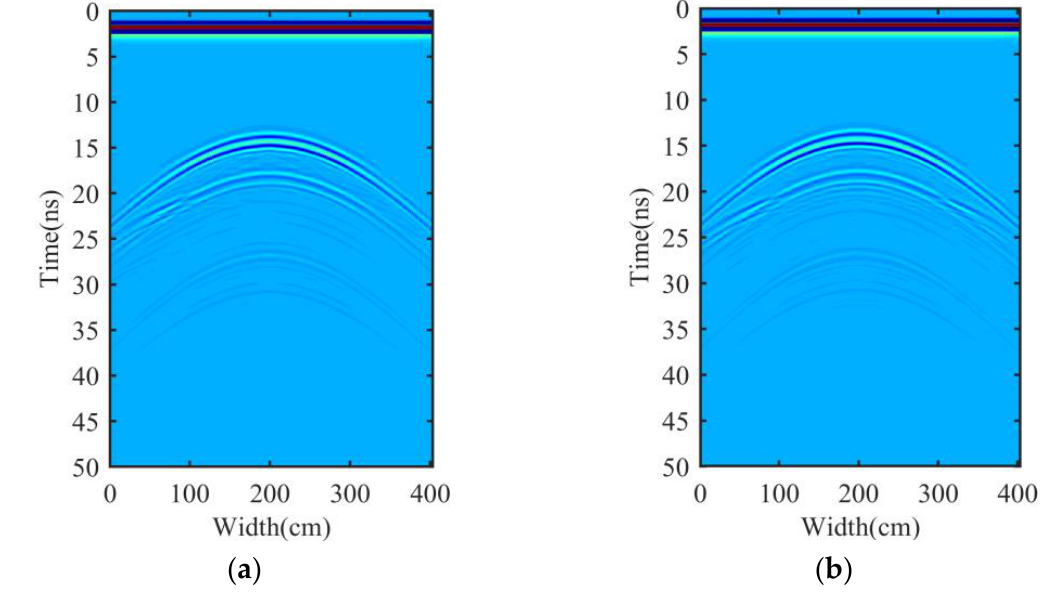
Figure 11. GPR B-scan image of a disease model with an irregular cavity below pipeline: ( a ) Obtained by non-conformal method; ( b ) Obtained by the conformal method.